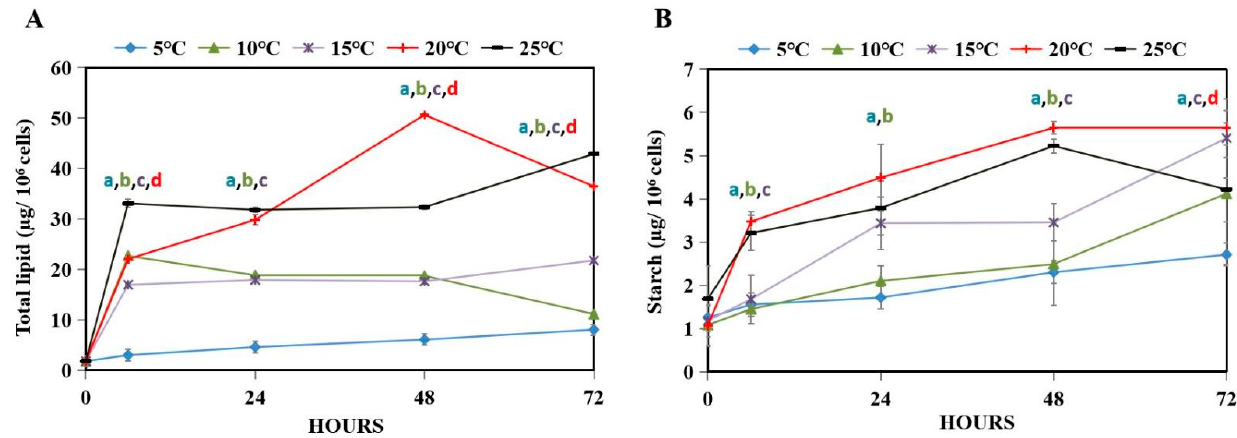
Figure 2. Lipid (A) and starch (B) content of C. reinhardtii cultivated under different temperatures. All data are means ± SD of three biological replicates. Different lowercase letters indicate significant differences between 25 °C and each temperature ( p < 0.05).